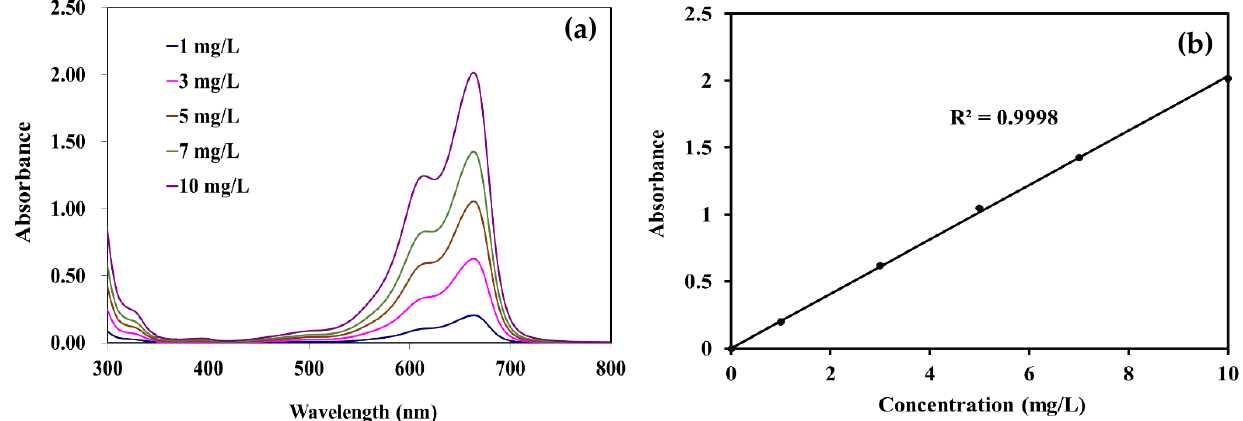
Figure 1. ( a )Wavelength–absorbancecurvesand( b Figure 1. ( a ) Wavelength – absorbance curves and ( b ) calibration curve of methylene blue aqueous solutions.